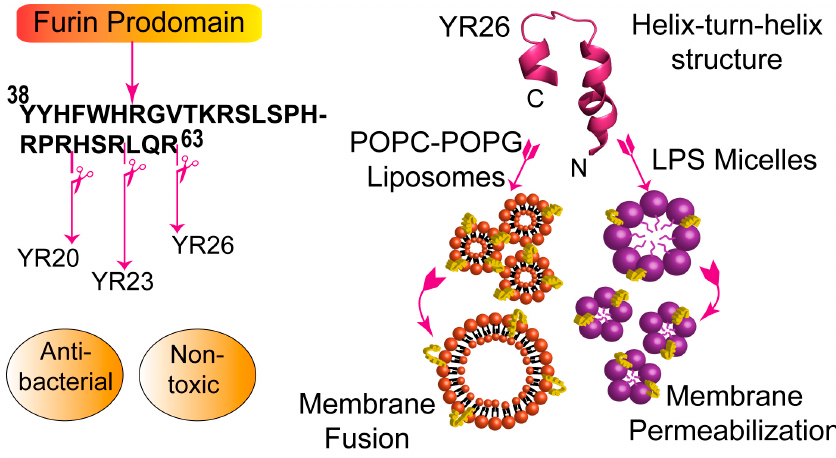
Figure 4. Truncation of furin prodomain to yield antimicrobial YR26, YR23, and YR20 (left). Structure and interaction of YR26 with model membranes (right). YR26 peptide assumed helix-turn-helix structure in SDS micelle and caused liposome fusion and LPS micelle dissociation. The figure was adapted from reference 176. The pdb accession code of YR26 is 6A8Y.